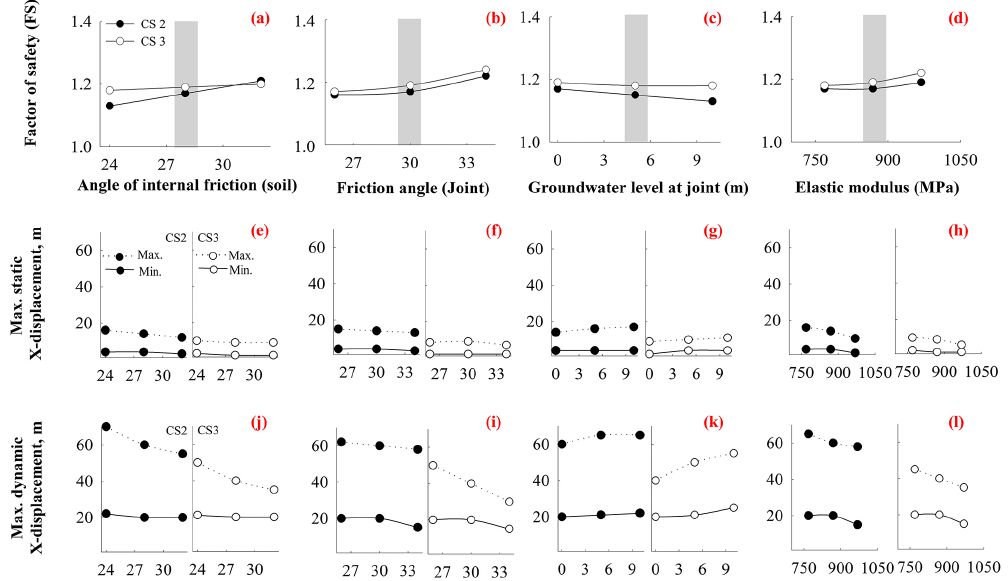
Figure 10. Parametric analysis. (a–d) Variation in the FS. (e–h) Variation in the static displacement. (i–l) Variation in the dynamic displace- ment. Grey bar represents the values that are used in the slope stability analysis (Sect. 4.1). Notably, vertical axes in (e) – (l) are kept the same to show relative increase in displacement under static and dynamic